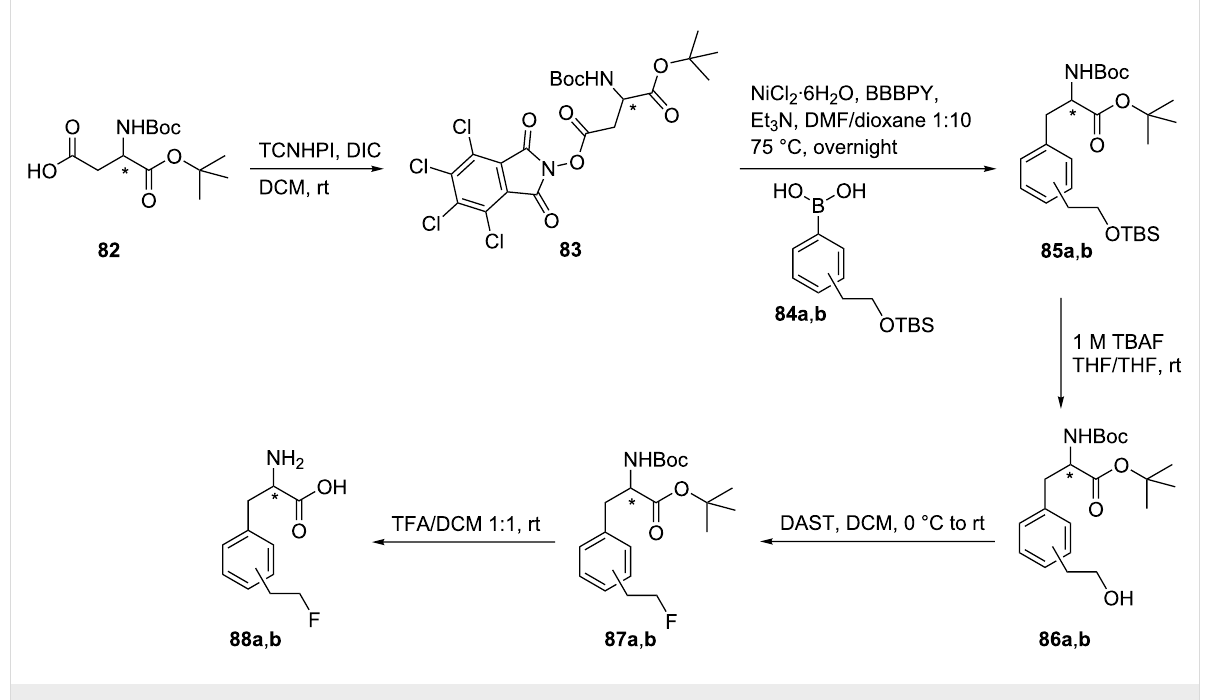
Scheme 20: Synthesis of FPhe derivatives 88a , b from aspartic acid derivatives.